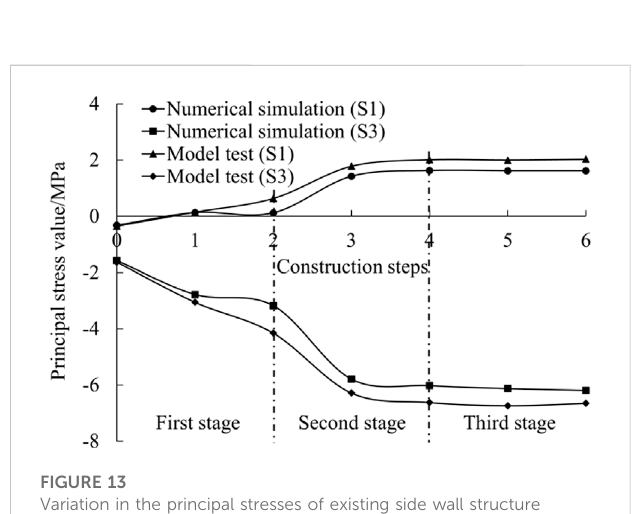
FIGURE 13 Variation in the principal stresses of existing side wall structure during opening construction.